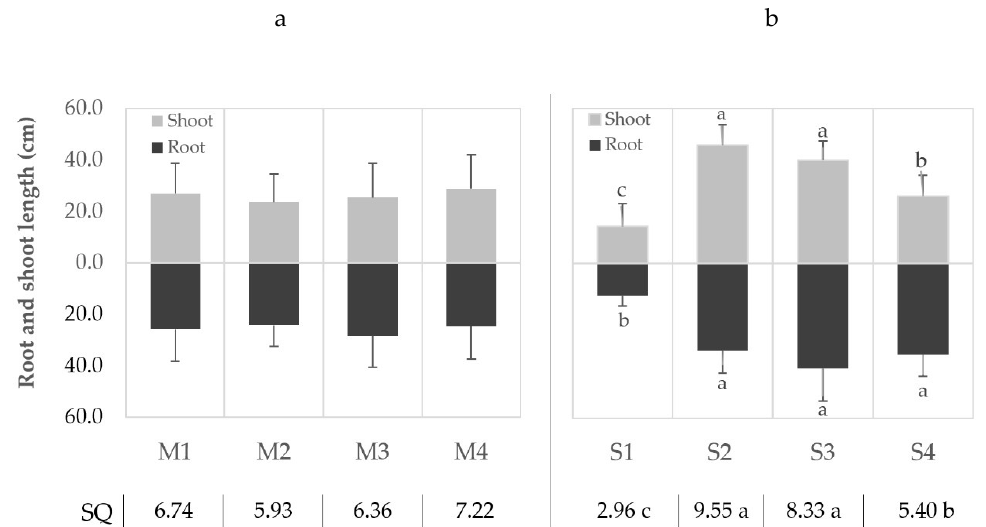
Figure 3. Effect of ( a ) medium (M) and ( b ) salinity (S) on the root and shoot length, as well as sturdiness quotient (SQ), of 14 week old Avicennia marina (Forssk.) Vierh. seedlings. Different letters above and below the bars indicate significant differences between treatments at α = 0.05. Note: S1: salinity < 5